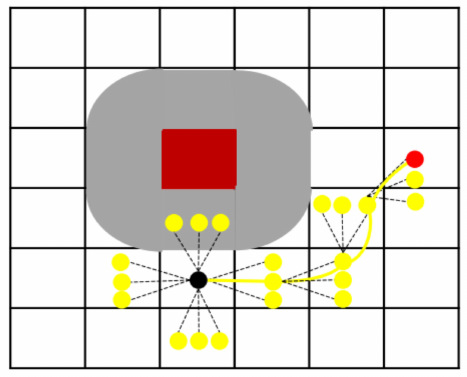
Figure 8. Ship path node search